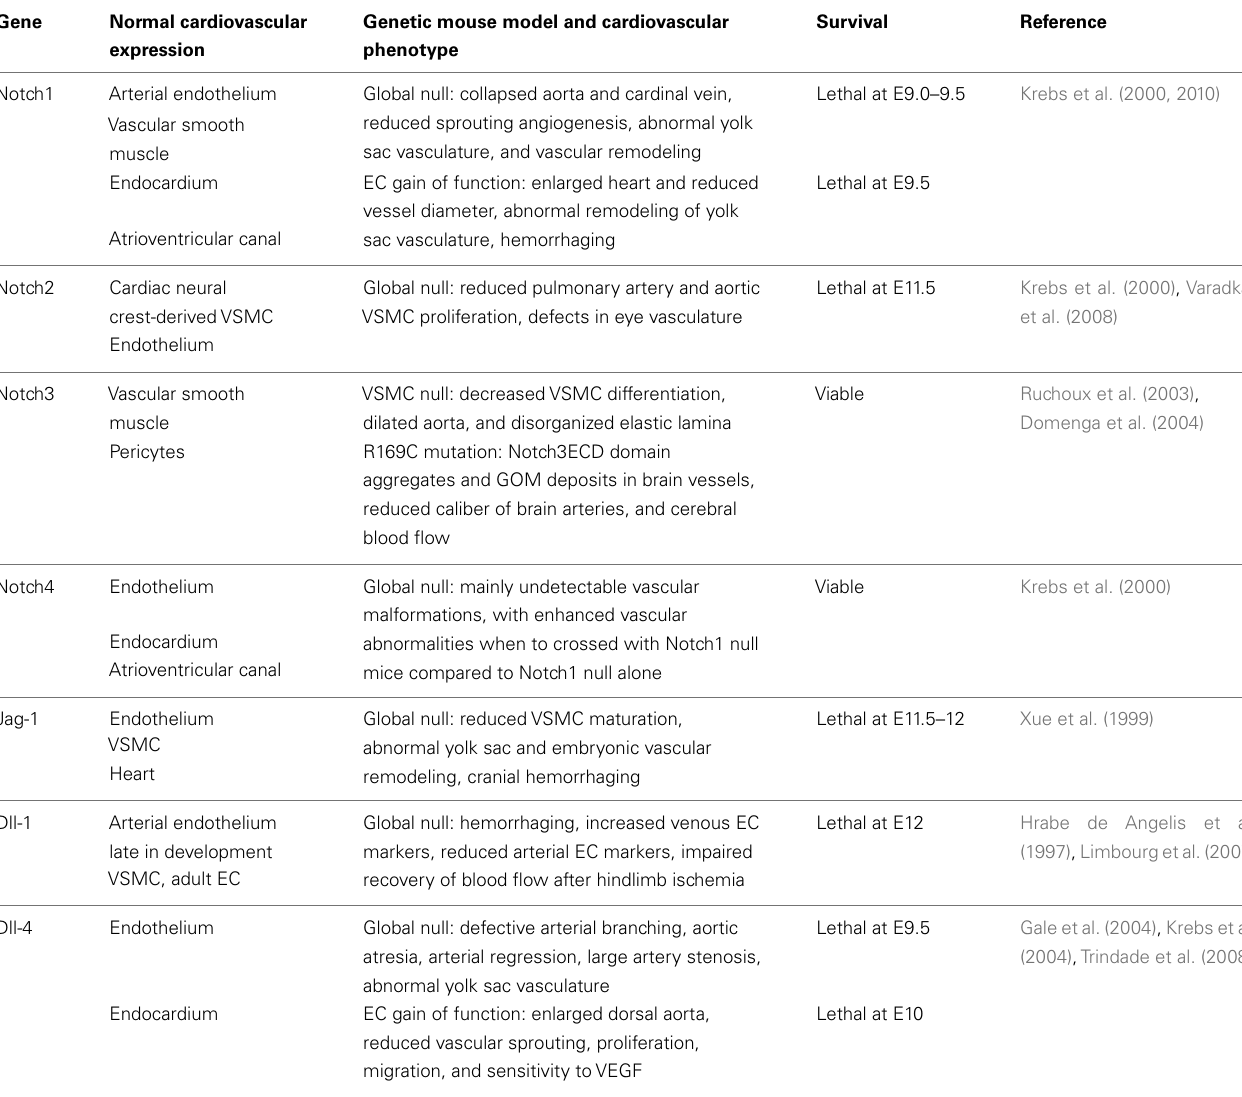
Table 1 | Notch cardiovascular phenotypes in mouse